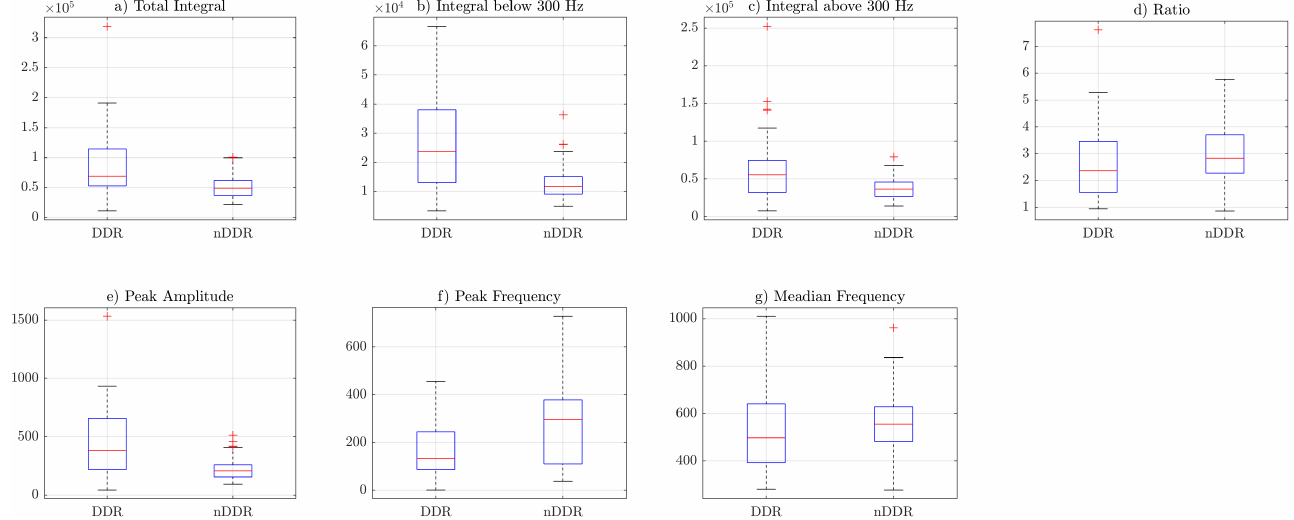
Figure A2. Box plots of raw features obtained for the second measurement: ( a ) TI feature, ( b ) IB3 feature, ( c ) IA3 feature, ( d ) IBAR feature, ( e ) PA feature, ( f ) PF feature, ( g ) MF